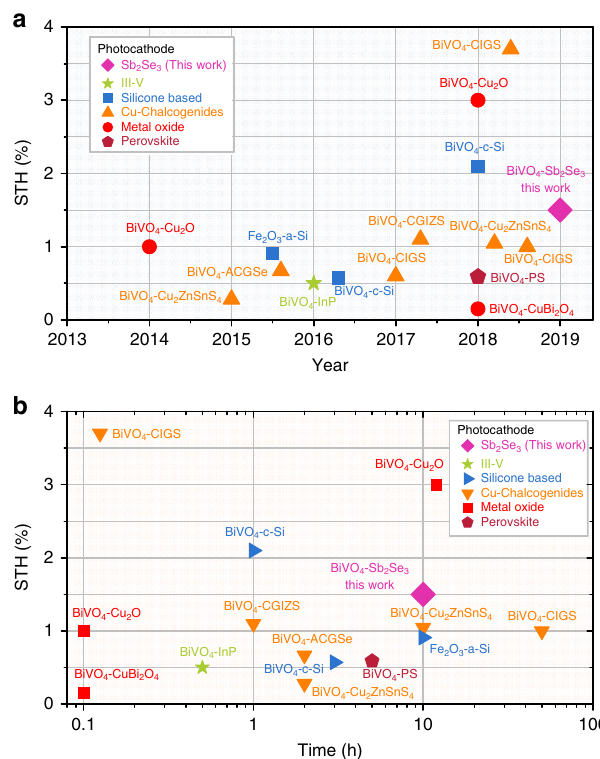
Fig. 6 Ef fi ciency and stability benchmarks for photoanode – photocathode D4 tandem cell. a Solar-to-hydrogen ef fi ciencies reported in recent years and b their operation duration. All reports are summarised in Supplementary Table